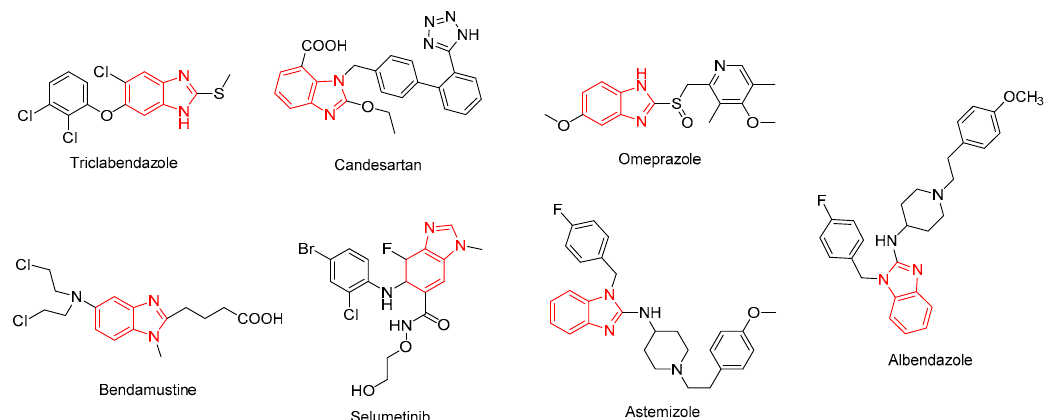
Figure 1. Drugs possessing benzimidazole motifs.